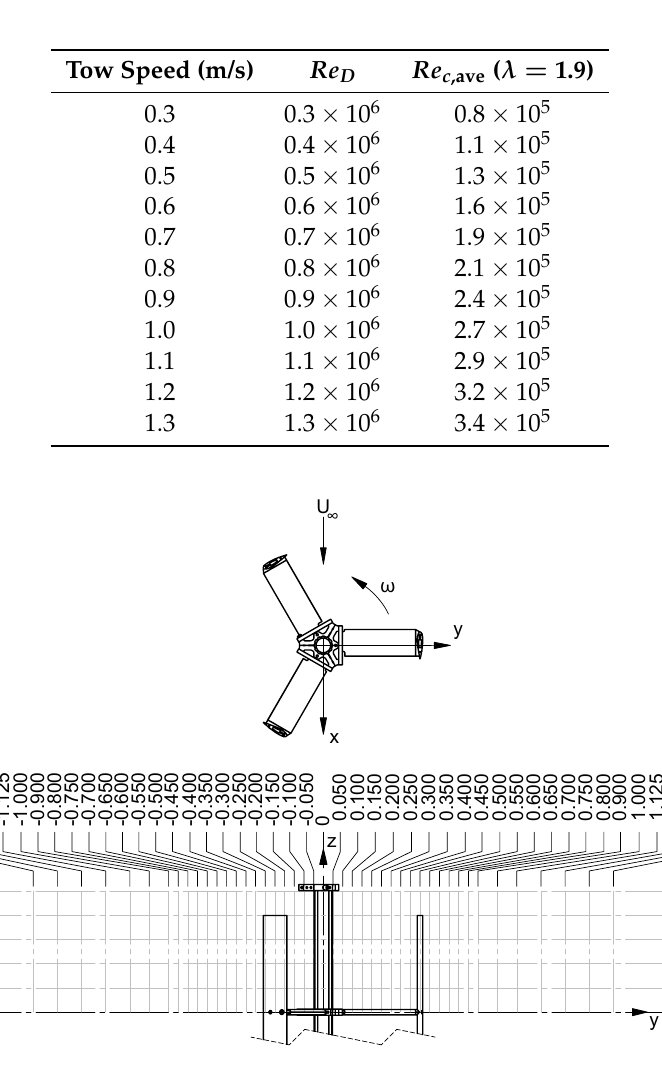
Table 1. Turbine diameter and approximate blade chord Reynolds numbers for the tow speeds used in the experiment.